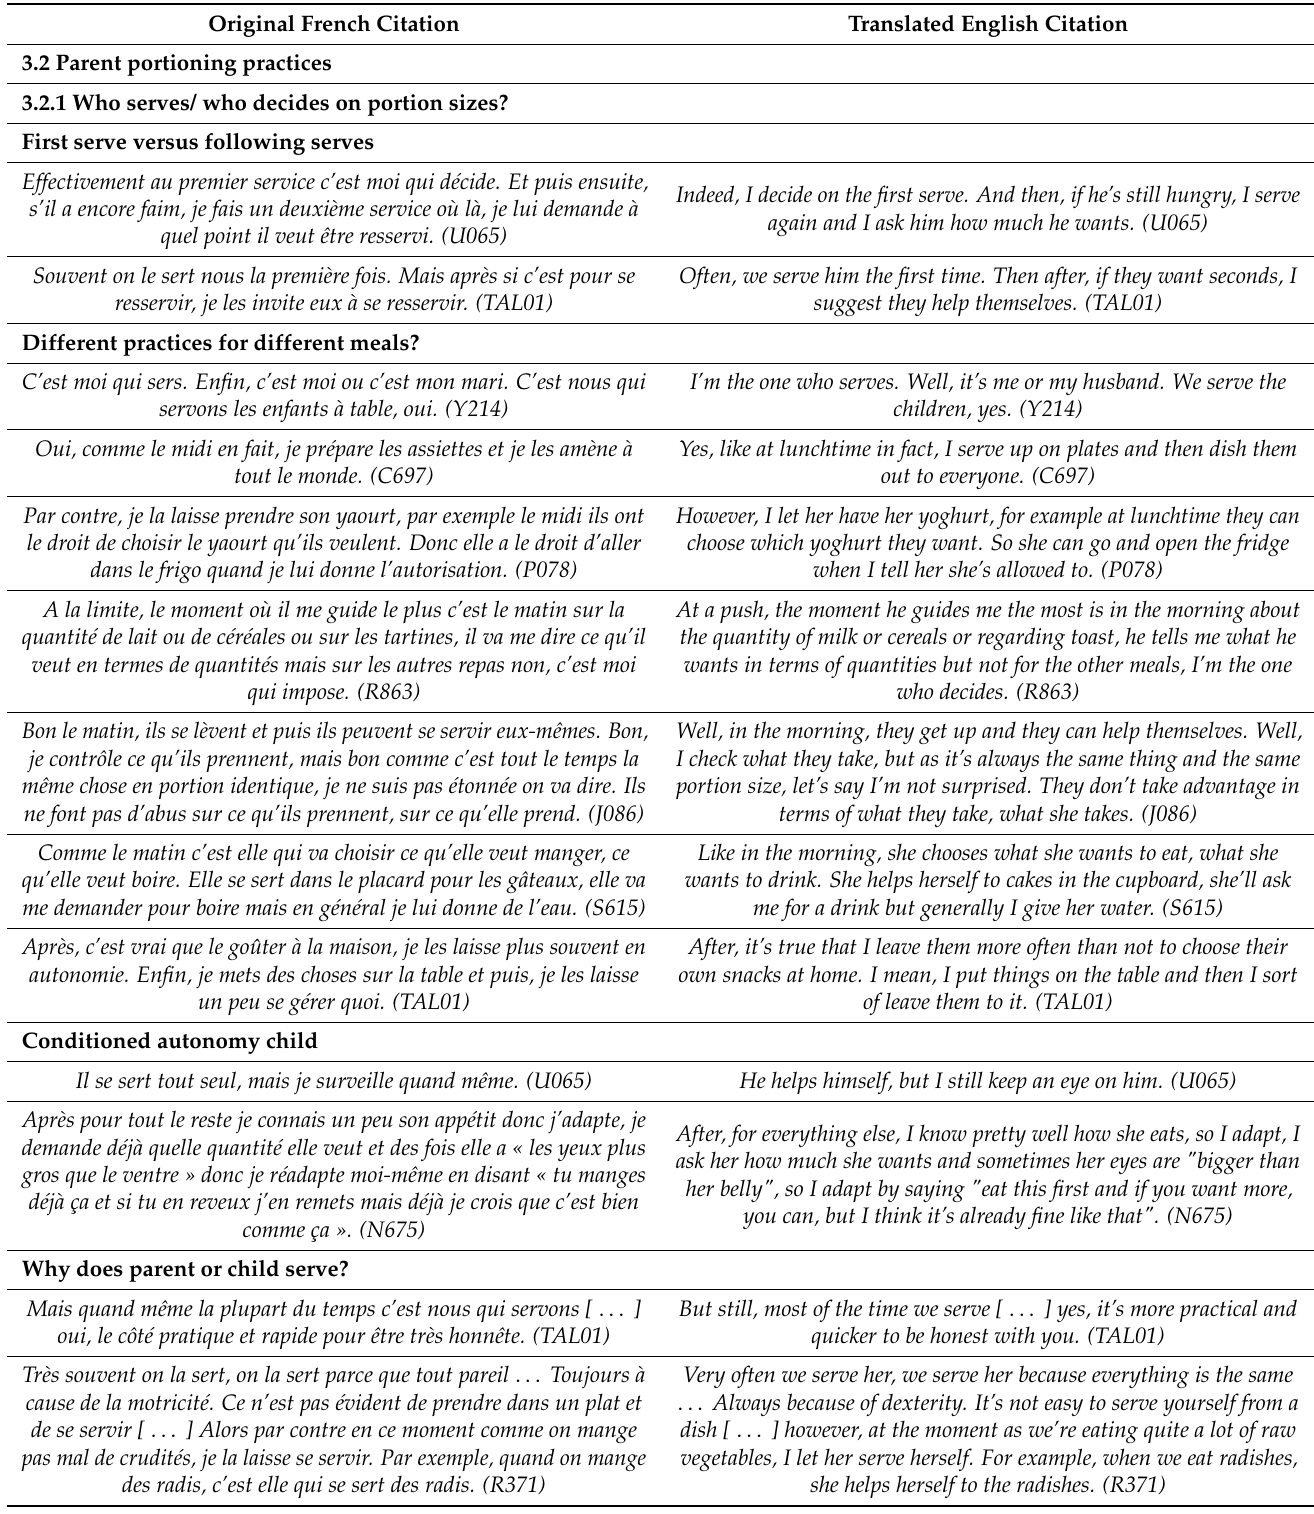
Table A2. Containing the original French citations used as illustrations in the article and their English